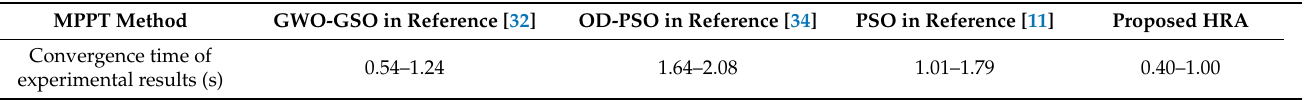
Table 6. Comparison of the experimental results of different